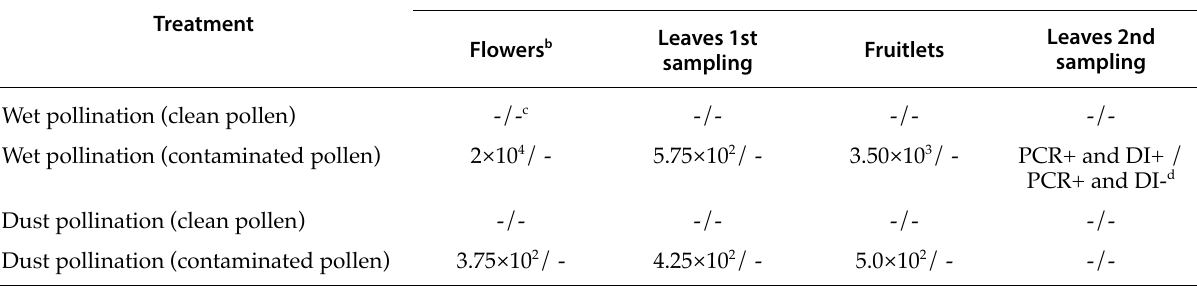
Table 1 . Establishment of detectable Pseudomonas syringae pv. actinidiae (Psa) populations on kiwifruit plants after pollina- tion with contaminated pollen (wet and dry pollination). On flowers and leaves (1st), sampling was carried out 24 h after pollination (first and second column). On fruitlets and leaves (2nd), sampling was 2 weeks after pollination (third and fourth column). From the third sampling, Psa populations on leaves and fruits were not calculated, but detection was done by PCR and direct isolation